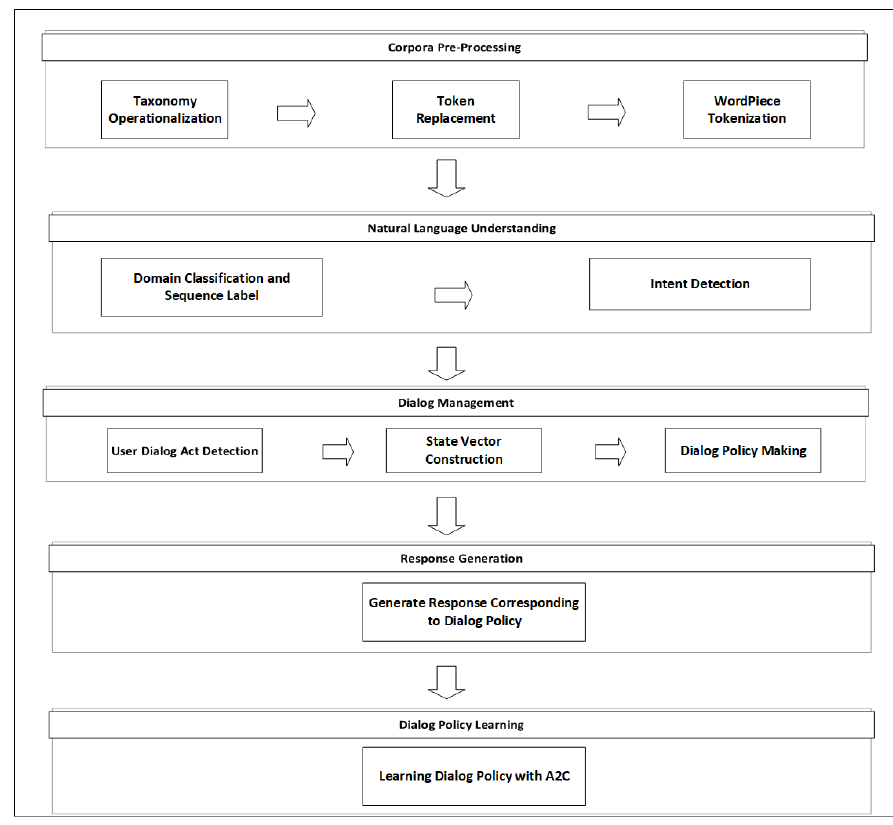
Figure 2. Architecture of